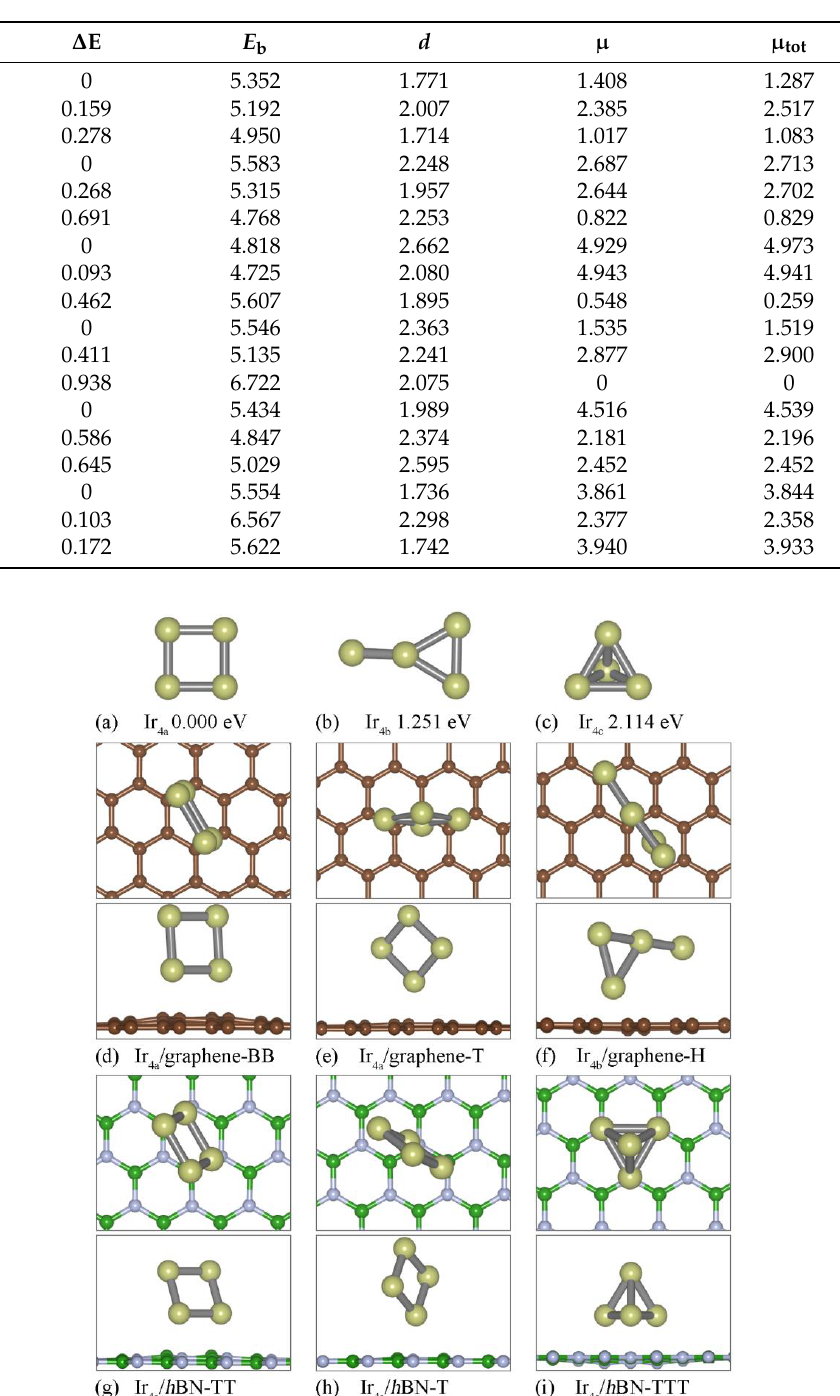
Figure 2. Atomic structures of the ( a ) Ir 4a (square planar model), ( b ) Ir 4b (a triangle configuration adding the fourth atom attached with the vertex of the triangle) and ( c ) Ir 4c (tetrahedral model) clusters. Top and side view of the three relative stable atomic structures of the Ir 4 cluster adsorbed on the graphene ( d – f ) and h BN ( g – i ) substrate, respectively. The free − standing Ir 5 isomers are listed in Figure 3a – c, in which Ir 5a (square pyramid model) is the most stable configuration, and the metastable ones are Ir 5b (square adding a co-plane triangle model, with an Δ E of 0.24 eV) and Ir 5c (triangular bipyramid model, with an Δ E of 1.117 eV), respectively. When it is absorbed on the 2D substrates, the square pyramid Ir 5a is still the most stable. A previous theoretical calculation also suggested that the square pyramid model of Ir 5 is more stable for both free − standing clusters [22,33,41] or on the monolayer graphene [43]. As shown in Figure 3d,g, the bottommost Ir atom of the cluster is located at the H site of the graphene ( h BN) with a d of 1.989 (1.736) Å . Ir 5c / h BN-T is metastable owing to its higher E b (6.567 eV), which is larger than that of Ir 5b / h BN-H (5.622 eV).